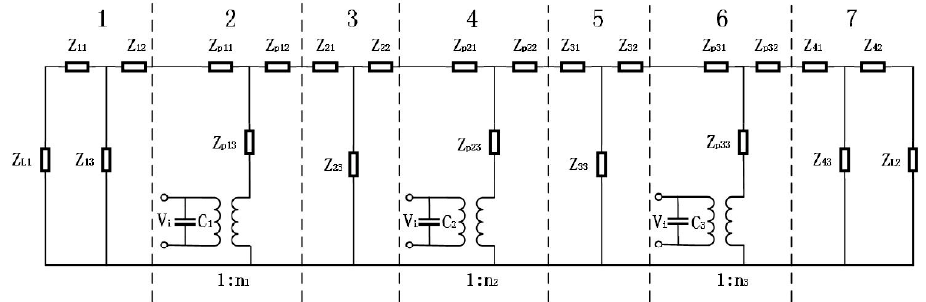
Figure 12. Electromechanical equivalent circuit of cascaded piezoelectric transducer.